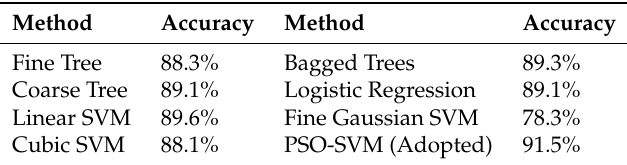
Table 1. Results of the